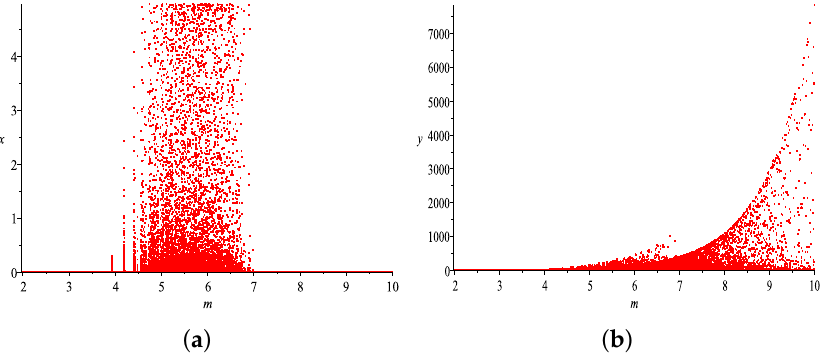
Figure 3. ( a ) The population density of prey varies with bifurcating parameter m . ( b ) The population density of predator varies with bifurcating parameter m